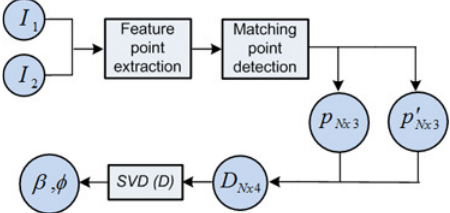
Figure 10. Observation model is embedded in the block diagram for the Scheme